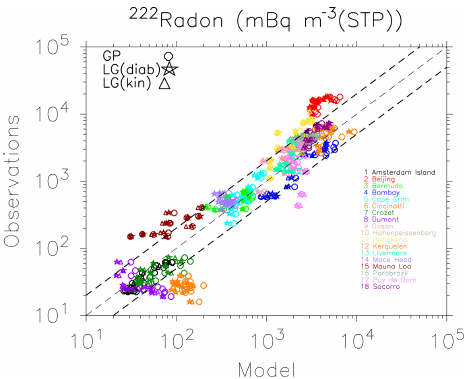
Figure 4. Monthly mean 222 Rn mBqm − 3 ( STP ) surface concen- trations: GP and LG model results against observations at different sites from Zhang et al. (2008). The thick dashed lines include a range within a factor of 2 of the